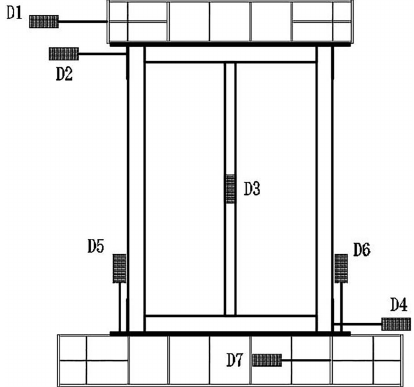
Figure 3. Displacement measuring